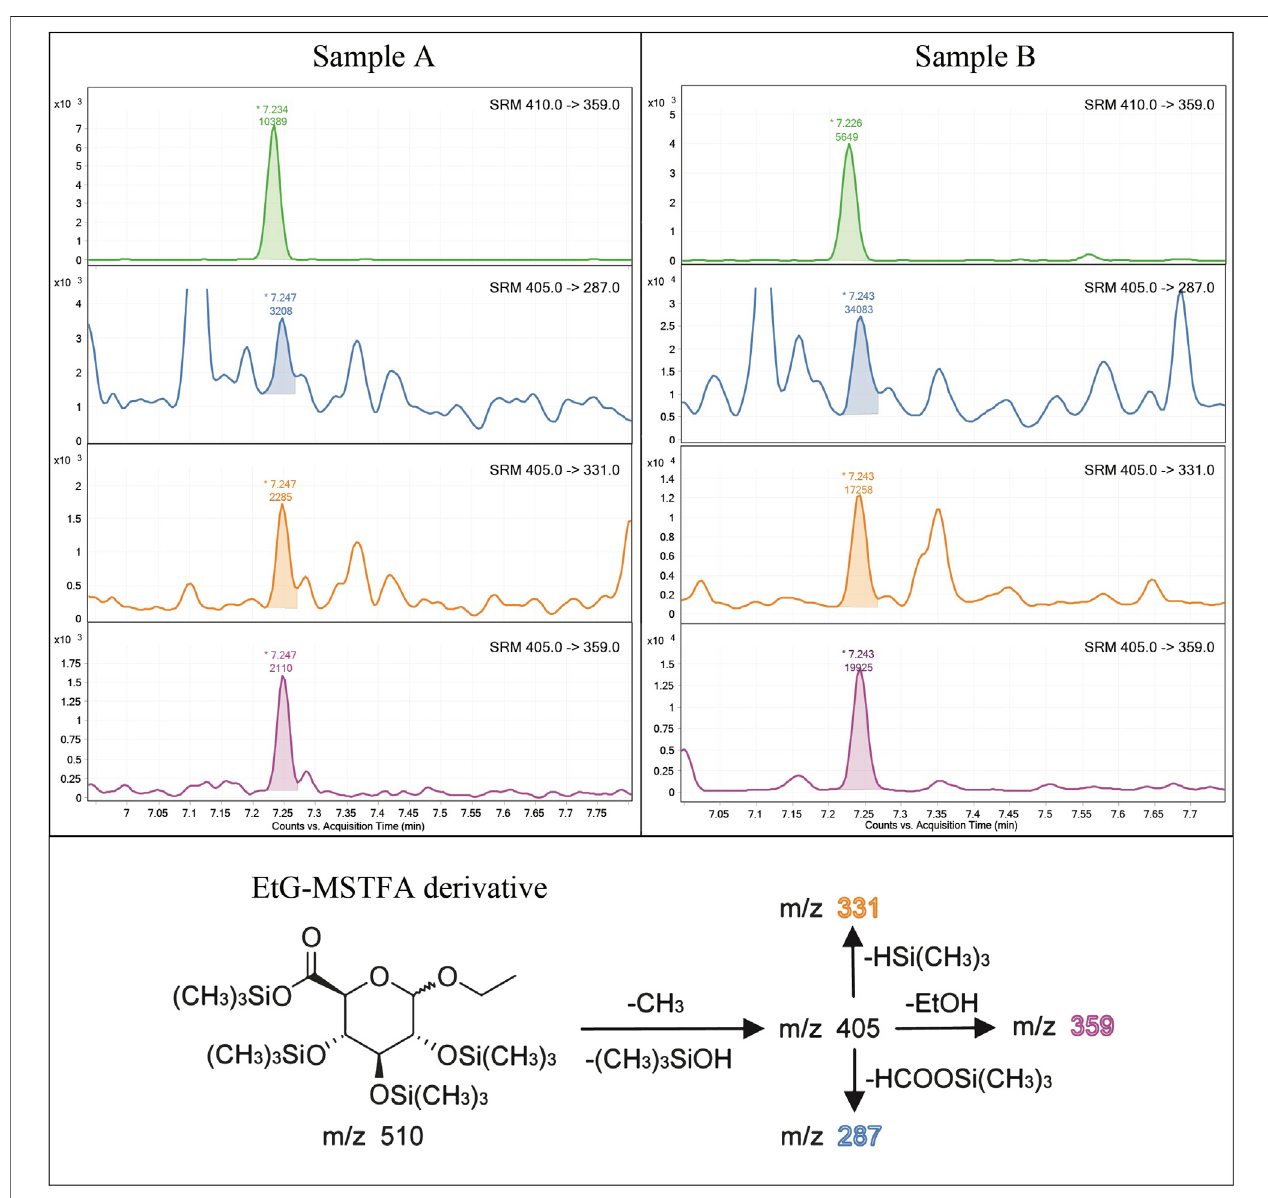
FIGURE 1 | Example of chromatograms acquired in the MRM mode on a 6 pg/mg (LOQ) spiked (A) and a real hair sample of a strong drinker subject (B) with an estimated EtG concentration of 127 pg/mg. For each sample are reported, from the top to bottom, SRM transition of IS (EtG-D5), two quali fi er SRMs, and the quali fi er SRM. The fragmentation mechanism of the derivatized EtG and the related ion fragments of the selected SRM transitions are also shown in the lower part of the fi gure.